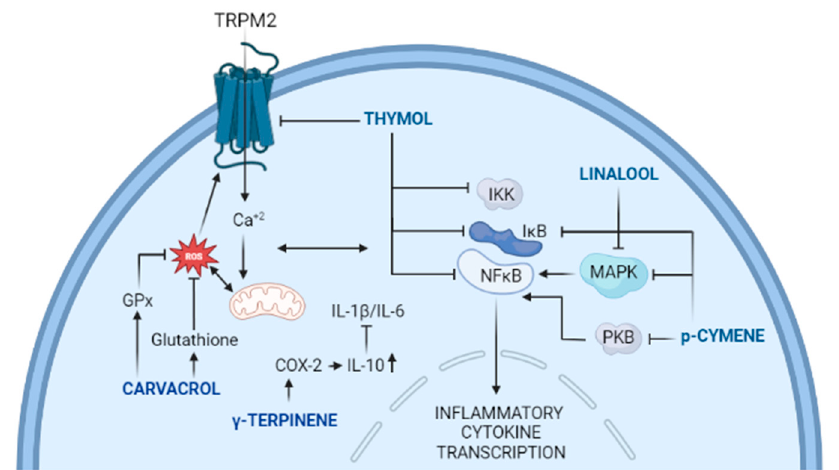
Figure 2. A simplified schematic depiction of the anti-inflammatory pathways utilized by thymol, Figure 2. A simpli fi ed schematic depiction of the anti-in fl ammatory pathways utilized by thymol, carvacrol, p-cymene, γ -terpinene, and carvacrol, p-cymene, γ -terpinene, and linalool.